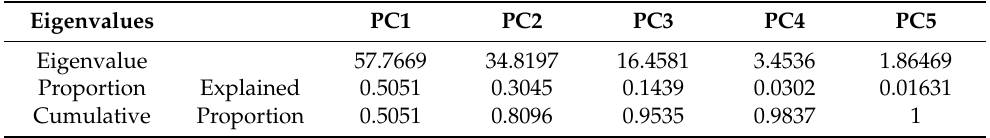
Table 4. PCA analysis results, eigenvalues of the five axes and proportion of variance explained.